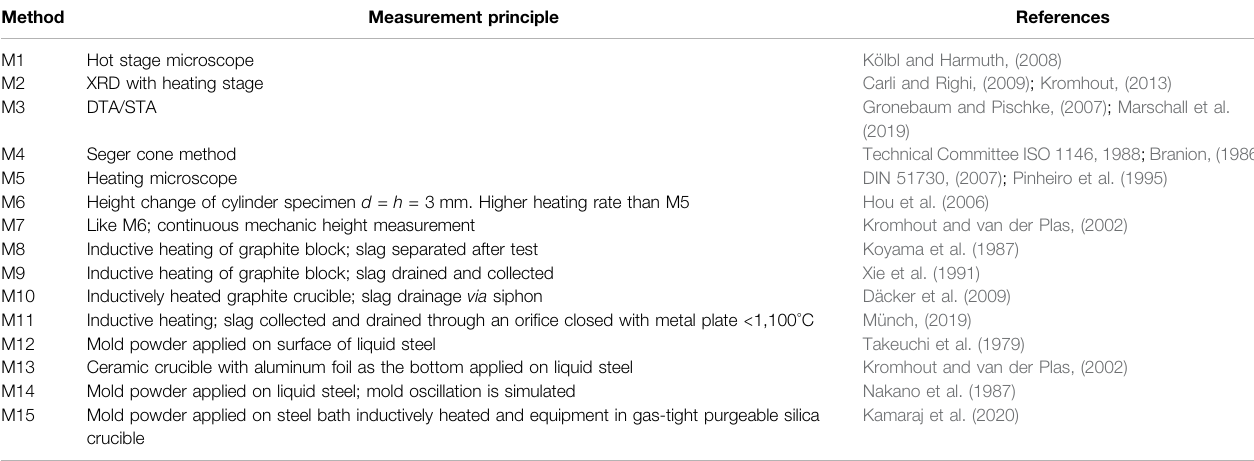
TABLE 1 | Overview of methods M1 – M15 as described in the